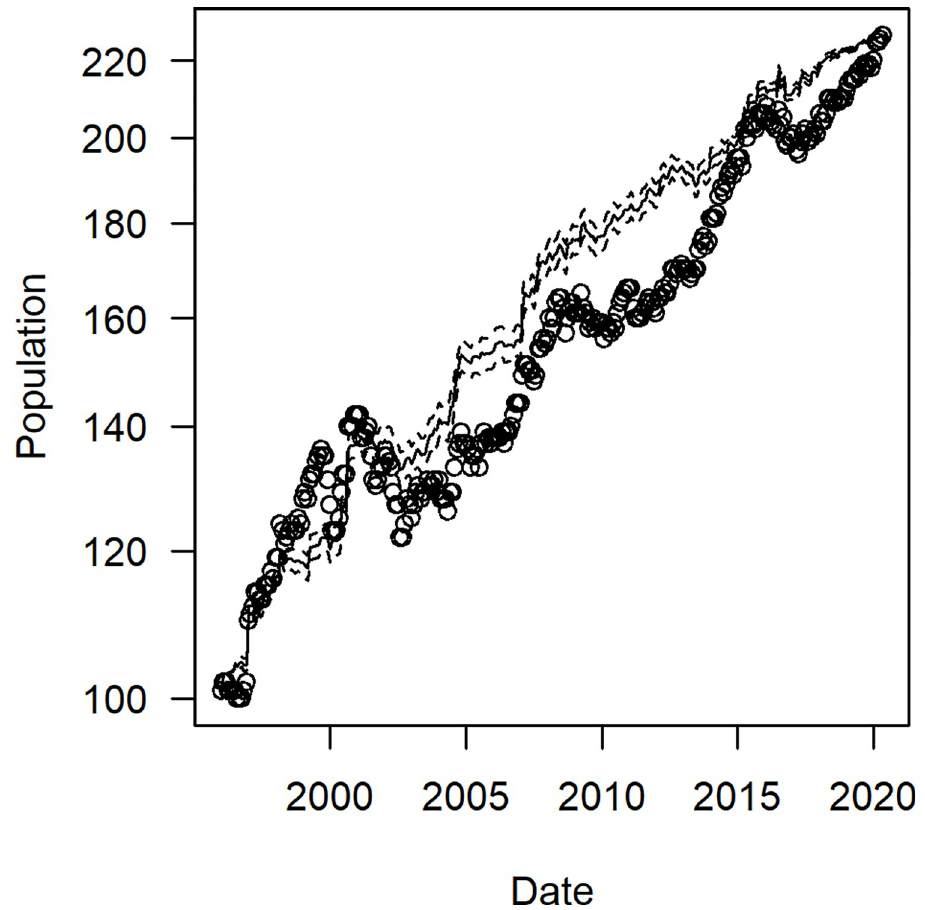
Fig 1. Temporal variations in the size of the study population. The solid line is the prediction from a linear regression and the dashed lines show the 95% prediction intervals. The y-axis has a log-scale so a constant rate of increase appears as a straight line. The slope of the line indicates that the population increased at an average annual rate of 2.9%, versus the estimate of 3.4% that was based solely on the initial and final sizes.